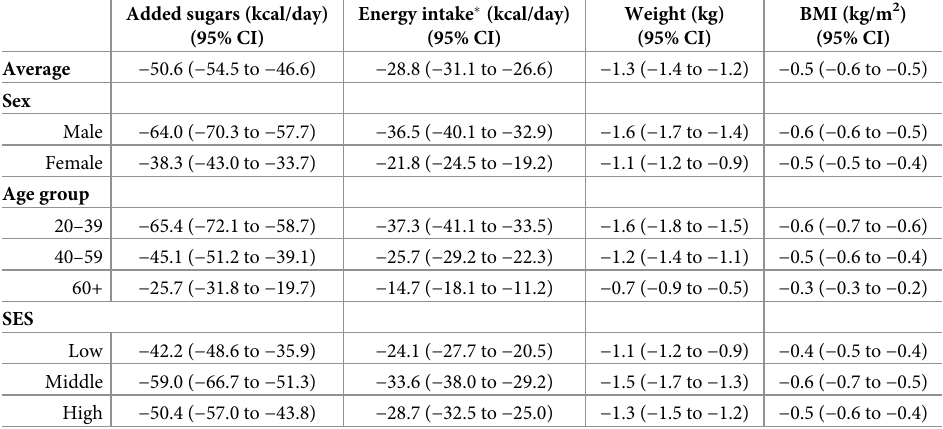
(cid:3) Net energetic change assuming 43% compensation for sources other than added sugars. Abbreviations: BMI, body mass index; SES, socioeconomic status; SSB, sugar-sweetened